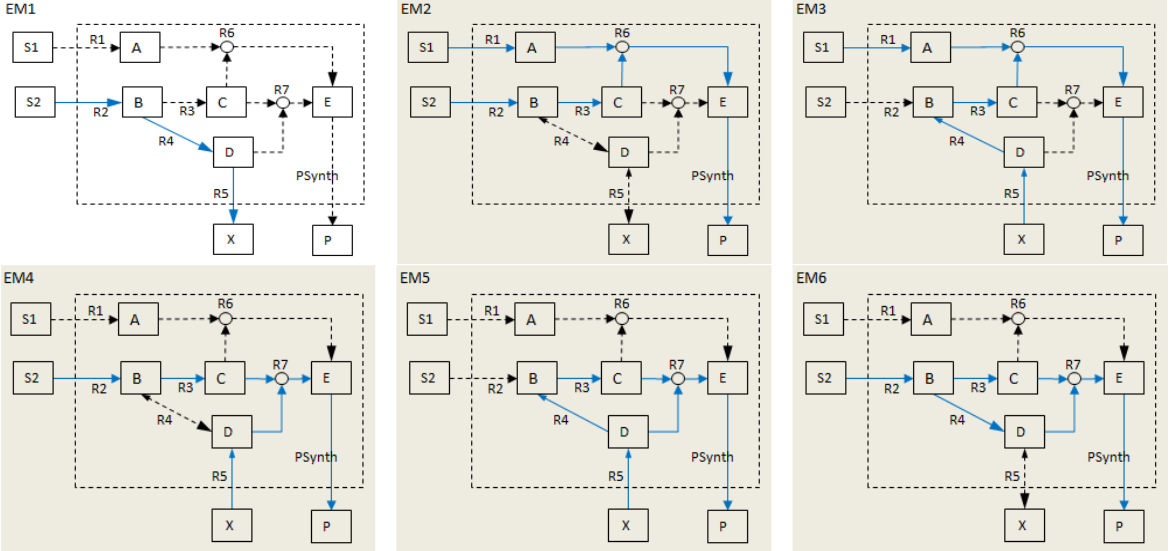
Figure 2. E lementary modes (EMs) for NetEx . The EMs are represented by the solid blue arrows. Adapted from